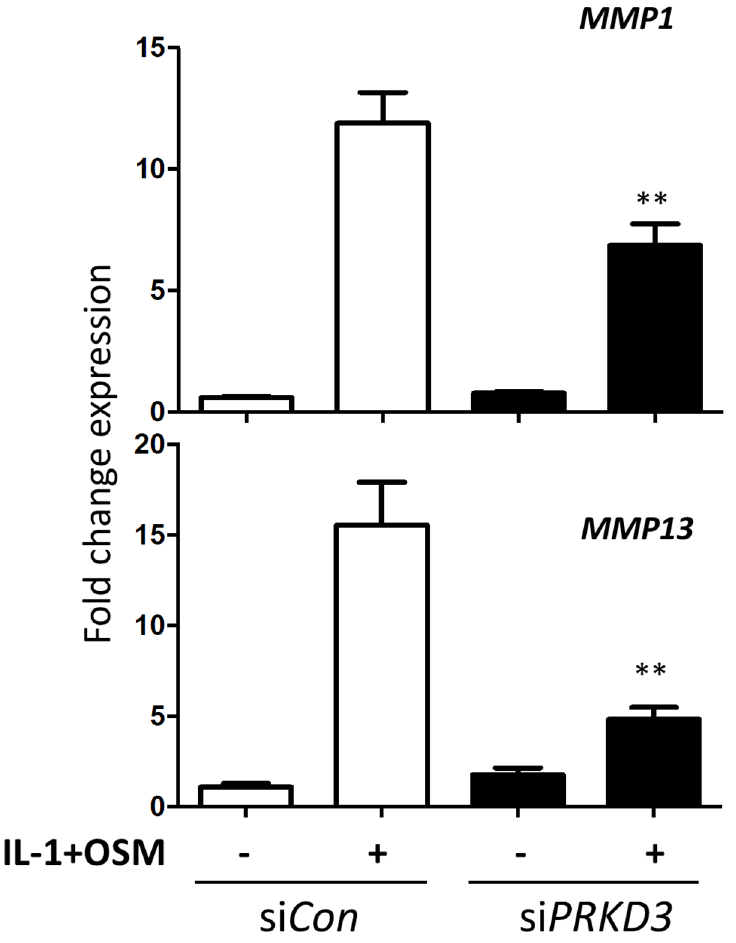
Fig 2. Effect of PKD isoform silencing on MMP1 and MMP13 expression in human chondrocytes. Following transfection with siRNA, either non-targeting siCon (white bars) or one specific for PRKD3 (black bars) (both 100 nM), primary human articular chondrocytes were stimulated with IL-1 (0.05 ng/ml) + OSM (10 ng/ml) for 24 h. Cells were lysed and real-time RT-PCR performed for MMP1 ( upper panel ) and MMP13 ( lower panel ), 72 h after the start of transfection as described in the Materials and Methods. Data (mean ± S.E.) are representative of at least three separate chondrocyte populations (each assayed in hextuplicate), presented as relative expression levels normalised to 18SrRNA housekeeping gene, where (cid:3)(cid:3) , p (cid:20) 0.01 versus siCon